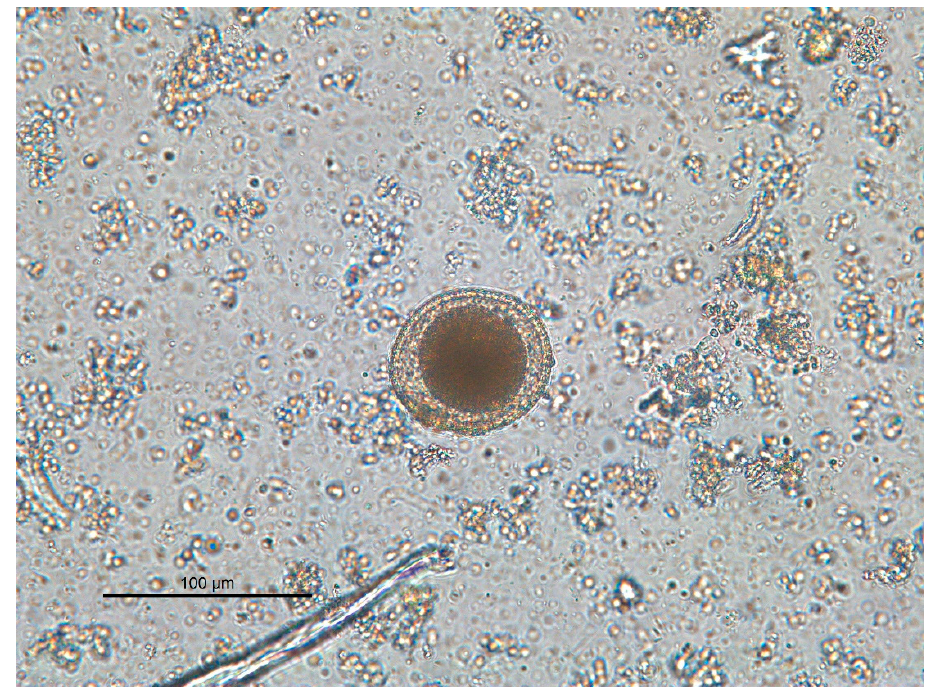
Figure 3. Toxocara spp. viable non-infective egg.